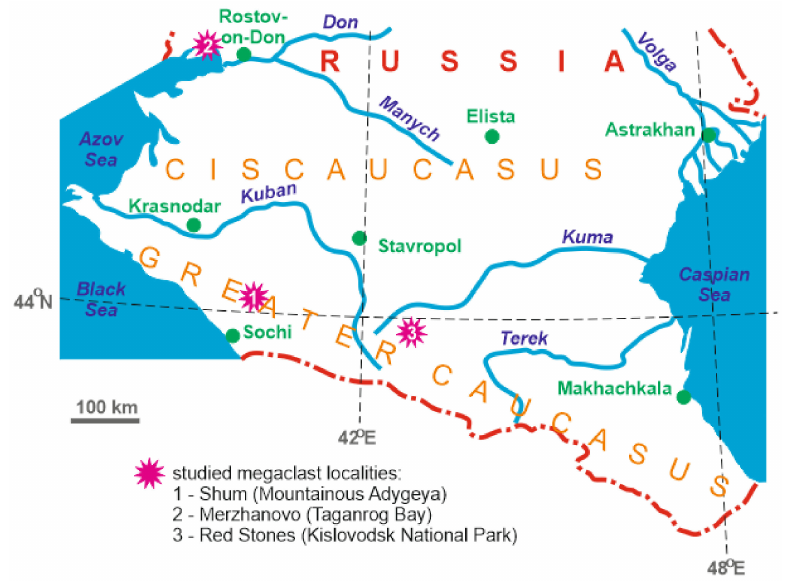
Figure 3. Megaclast localities of the Russian South considered in the present